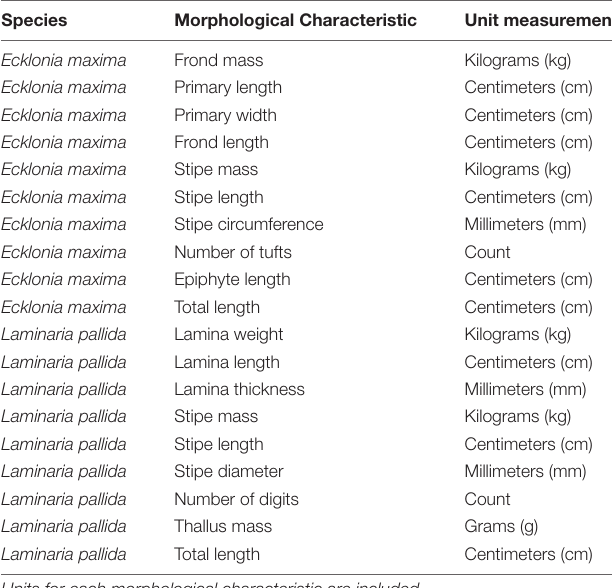
TABLE 1 | A list of morphological measurements that were collected for Ecklonia maxima and Laminaria pallida . Species